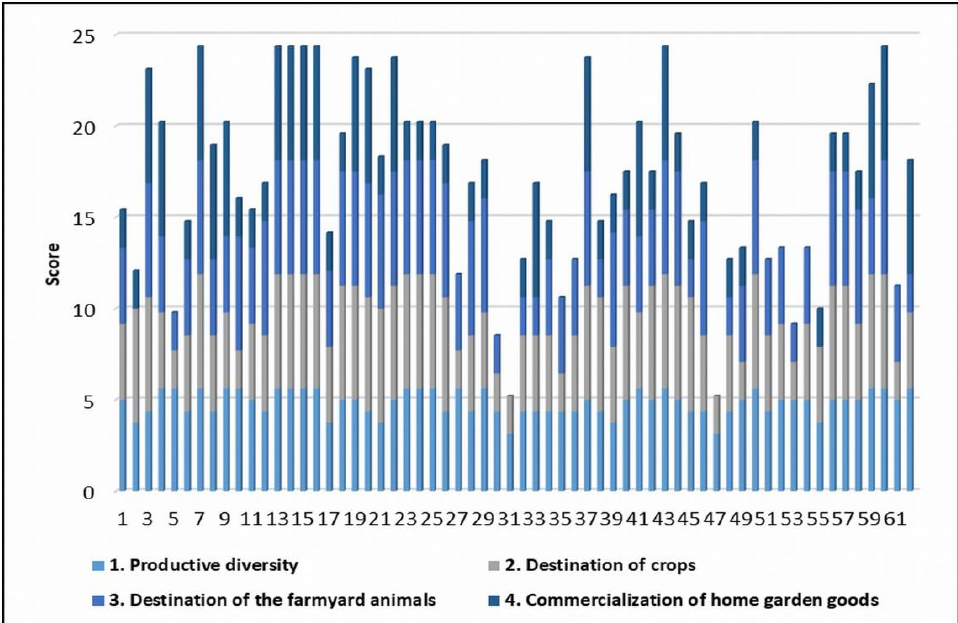
Figure 5. Accumulated value per home garden for the self-sufficiency indicators.